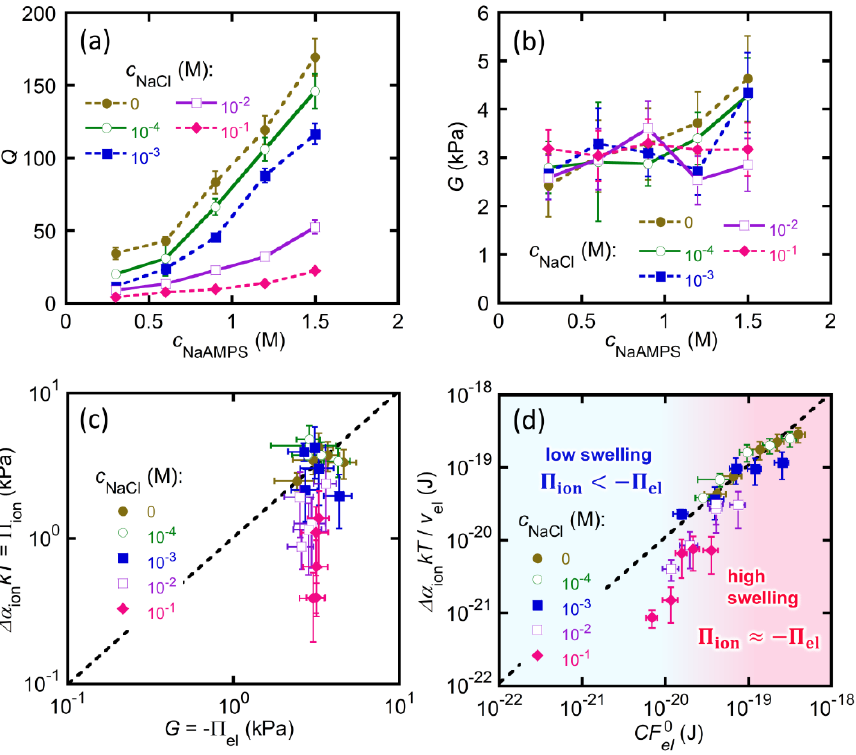
Figure 6. ( a ) Swelling ratio and ( b ) shear modulus of the St-tetra-PEG gels with varied 𝑐 NaAMPS depending on 𝑐 NaCl ; ( c ) G vs. Δ𝛼 ion 𝑘𝑇; and ( d ) 𝐶𝐹 el0 vs. Δ𝛼 ion ing on 𝑐 NaCl . Note that Δ𝛼 ion was not directly measured but estimated with Equations (16) and